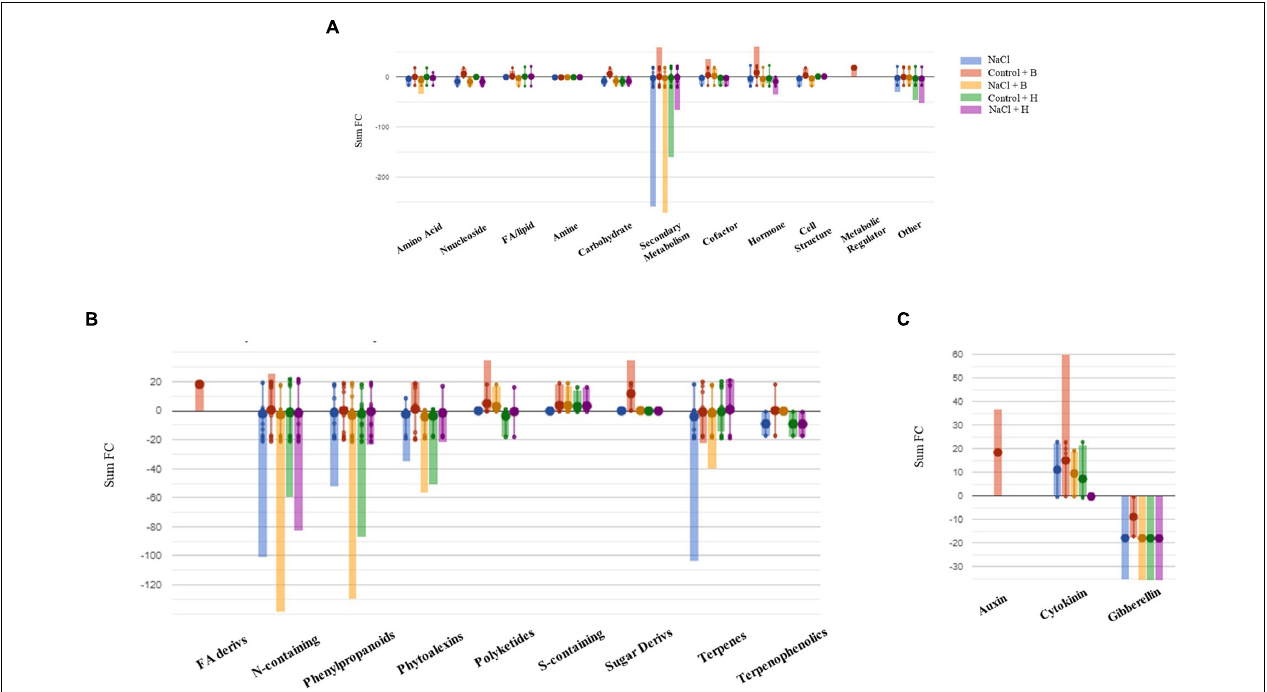
FIGURE 8 | Metabolic changes in tomato plants. Metabolic processes (A) , secondary metabolism (B) , and (C) hormone biosynthesis were impaired by treatments in tomato plants compared to control samples. Differential metabolites from the Volcano analysis ( P -value < 0.01, FC ≥ 1.3) were elaborated using the Omics Viewer Dashboard of the Plant Cyc pathway Tool software (www.pmn.plantcyc.com). The large dots represent the average (mean) of all log Fold-change (FC) for metabolites, and the small dots represent the individual log FC for each metabolite. The x -axis represents each set of subcategories, while the y -axis corresponds to the cumulative log FC. FA/Lipid: fatty acids and lipids, Amine: amines and polyamines, Cofactor: cofactors, prosthetic groups, electron carriers, and vitamins, FA Derives: fatty acid derivatives, N-containing: Nitrogen-containing secondary metabolites, S-containing: Sulfur-containing secondary metabolites, and Sugar Derives: sugar